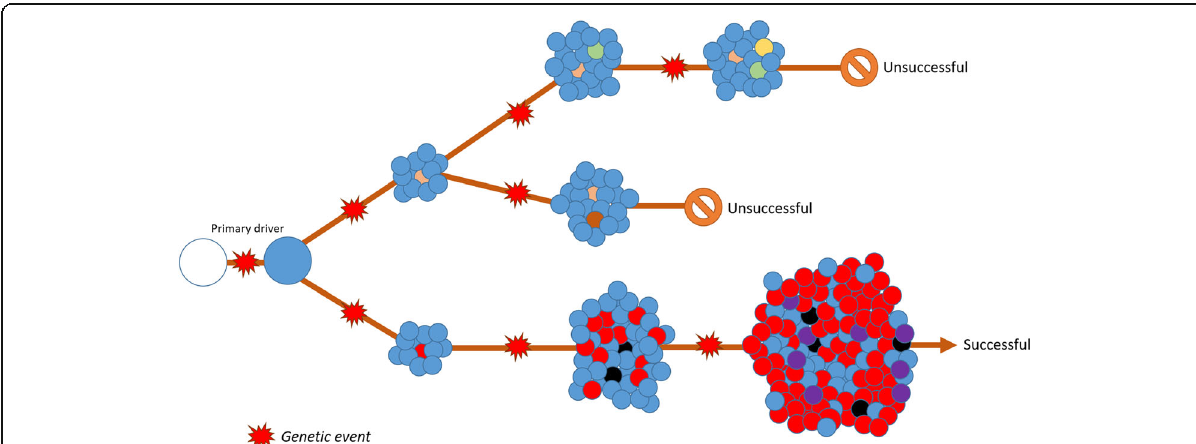
Fig. 1 Schematic representation of tumour development. Starting with one primary mutation, which differentiates healthy cells (empty circle) from an early tumour lesion (blue circle), many subsequent mutations are possible. The parental mutation will be present in all daughter cells (blue), while sub-clones are characterised by additional mutations. Non-tumorigenic mutations (beige, green, brown and yellow) do not lead to increased tumour growth, while tumorigenic mutations (red, black and purple) lead to successful tumour development. There are multiple ways a tumour can be unsuccessful, but there are limited ways to be successful